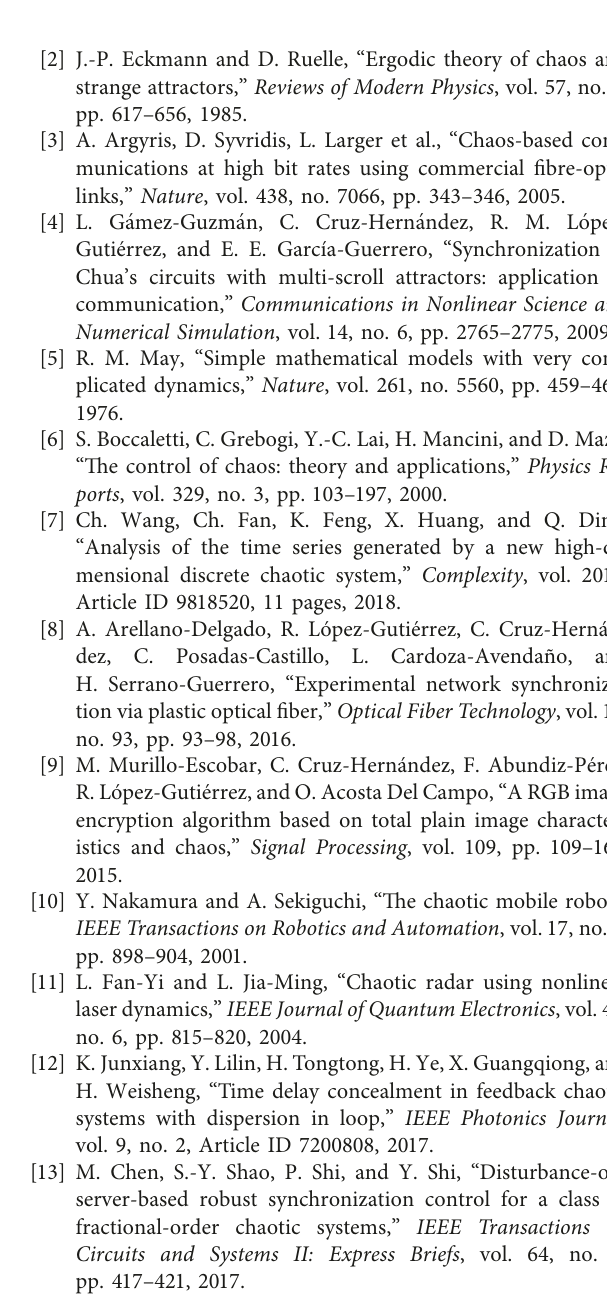
Figure 17: Robustness diagram of chaos existence varying two parameters at intervals of 0.05 and with τ according to five 3D CSs in their DVs using the NA (6)–(13): chaos (yellow); no chaos